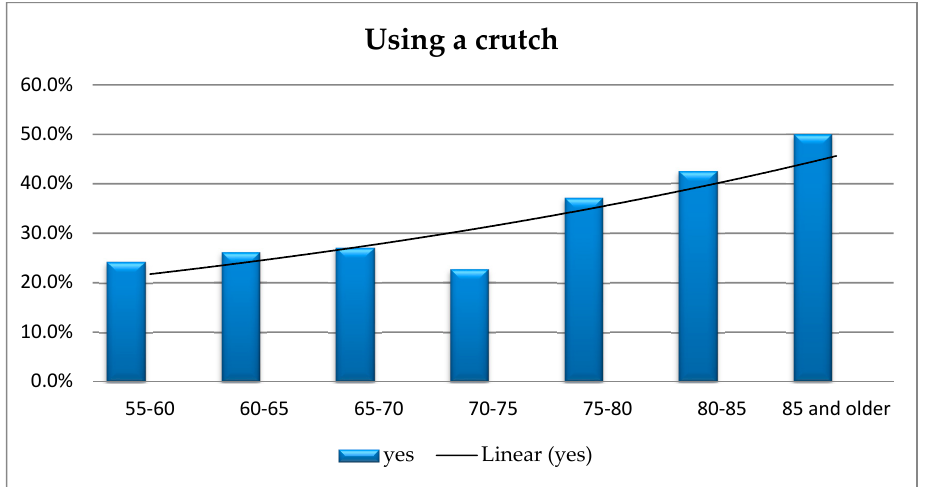
Figure 6. The respondents’ age vs. using a crutch.